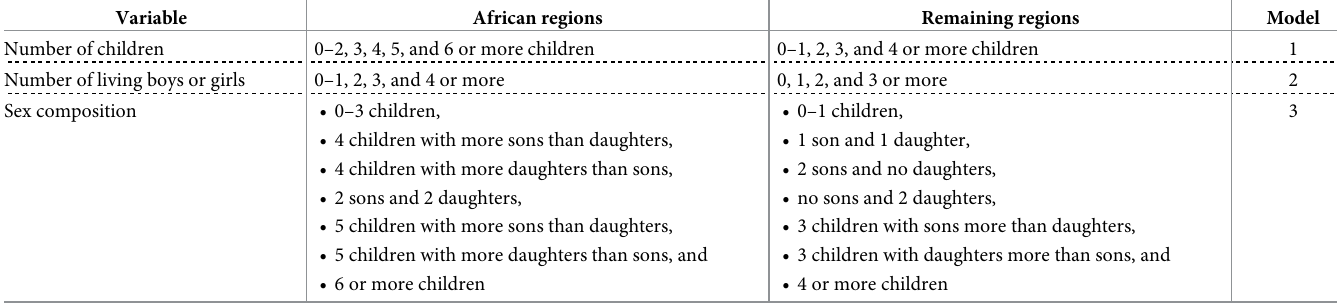
Table 2. Coding of fertility variables by